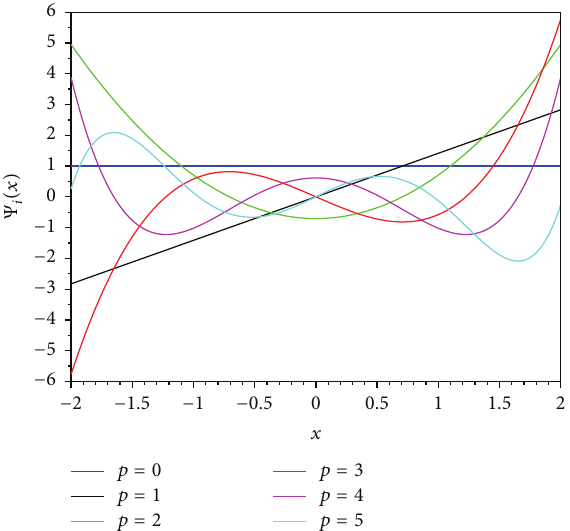
Figure 1: The Hermite polynomials up to degree 5 .